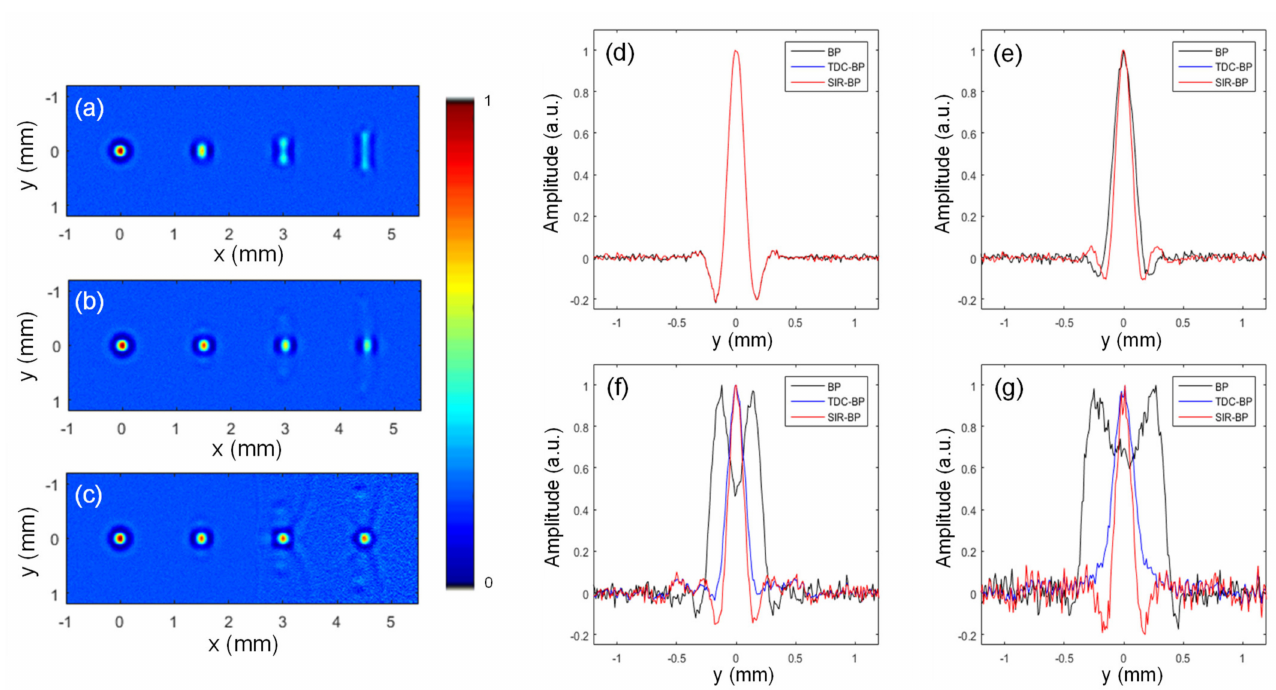
Figure 4. Simulation results for point targets imaged with different reconstruction methods. ( a ) The conventional BP method; ( b ) the TDC-BP method; ( c ) the SIR-BP method. The diameter of the employed planar transducer was 5 mm, and the four targets are at 0 mm, 1.5 mm, 3 mm, and 4.5 mm, respectively. ( d – g ) are the lateral profiles for the four targets obtained from ( a – c ). The black, blue and red lines represent the results from the conventional BP method, TDC-BP method, and SIR-BP method, respectively. The simulated data were added with 5 % noise. The amplitudes of these lines are normalized to 1 for